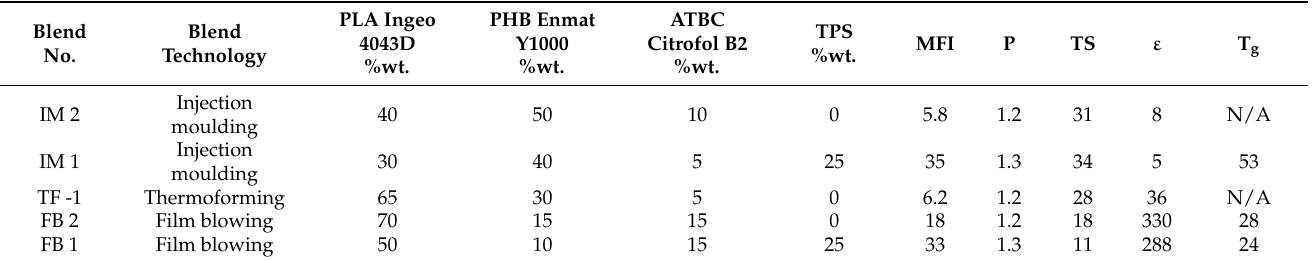
Table 1. Basic characteristics of the tested materials.